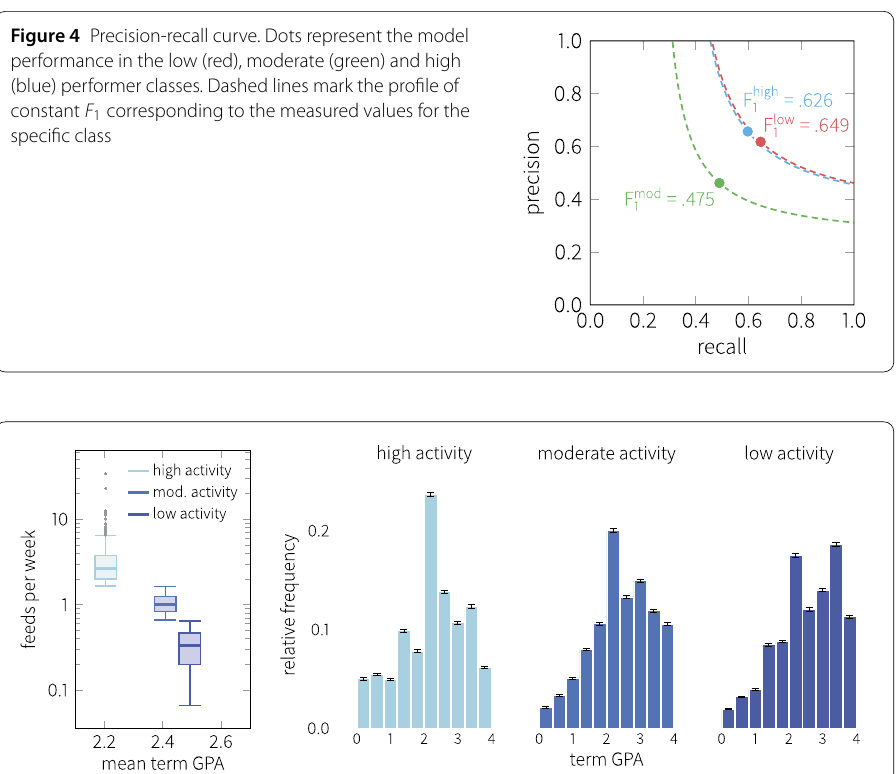
Figure 5 Facebook usage and performance in the tertiles. ( a ) Division of students into three groups of equal size according to their active Facebook updates. Each box represents a single tertile, width corresponds to the span of Facebook activity in the specific group and the x -position shows the mean term GPA. ( b ) Grade distribution inside each Facebook activity